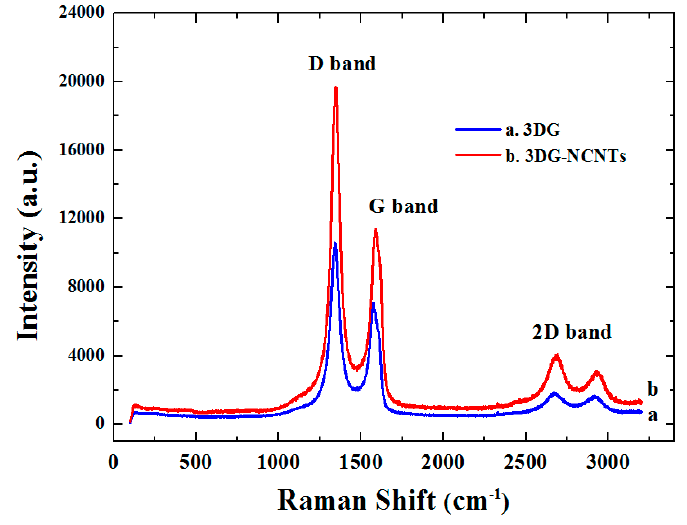
Figure 4. Raman spectra of 3DG (curve a ) and 3DG-NCNTs (curve b ) modified GC electrode.